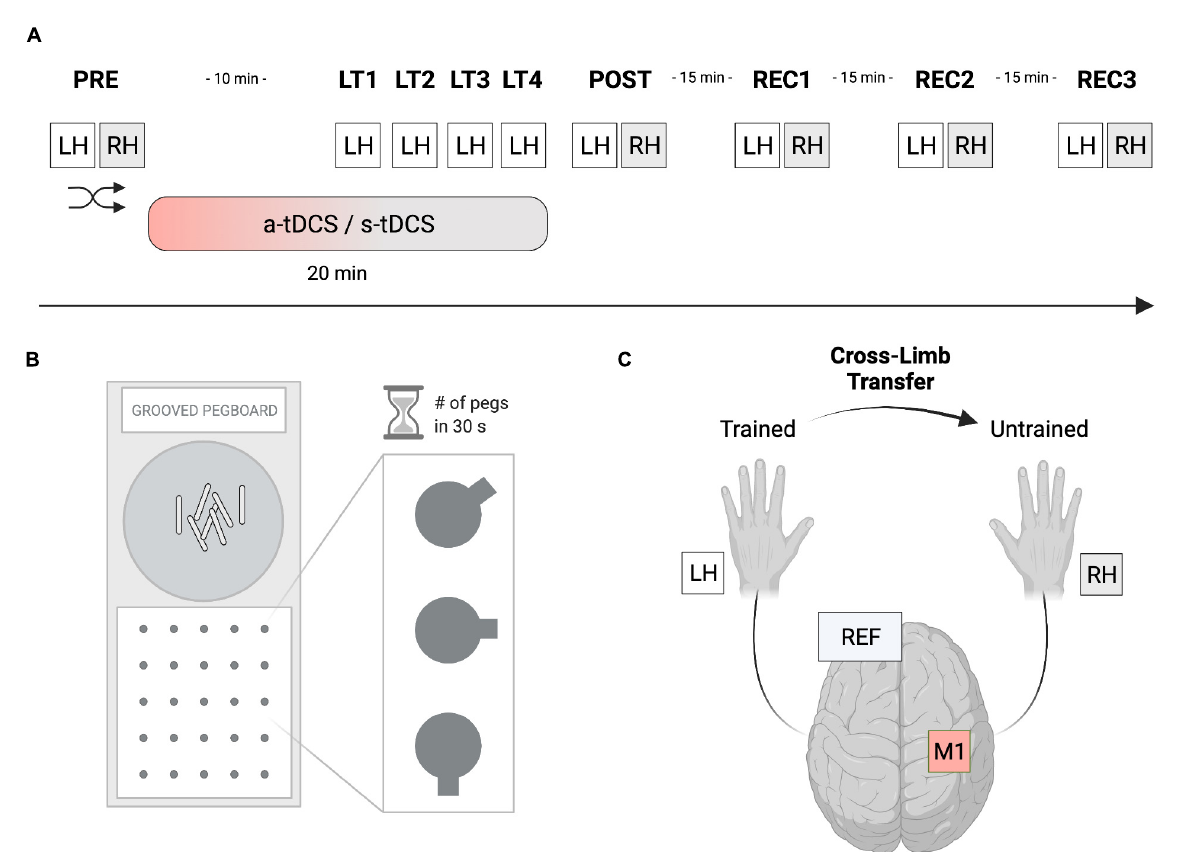
FIGURE1 Experimental setup. (A) In this randomized, double-blinded, sham-controlled study, participants had to perform a manual dexterity task called the Grooved Pegboard Test (GPT). The baseline performance of both hands was assessed (PRE), before performance of the left hand (LH trained ) was investigated during 4 learning trials (LT1-LT4). Thereafter, performance improvements of both hands were reassessed (POST). Furthermore, 3 recovery trials (REC1-REC3) were performed, separated by 15 min of rest to assess tDCS after-effects. Anodal transcranial direct current stimulation (a-tDCS) or sham stimulation (s-tDCS) was applied for 20 min during motor practice of LH trained . The order of left- or right-hand testing was randomized per timepoint. (B) The Grooved Pegboard Test (GPT) was implemented to investigate eye-hand coordination and motor speed for manual dexterity. (C) During a-tDCS and s-tDCS, LH trained performed the GPT while RH untrained was resting. Anodal tDCS of the right M1 was applied for 20 min with the reference electrode placed on the left supraorbital cortex. Created with